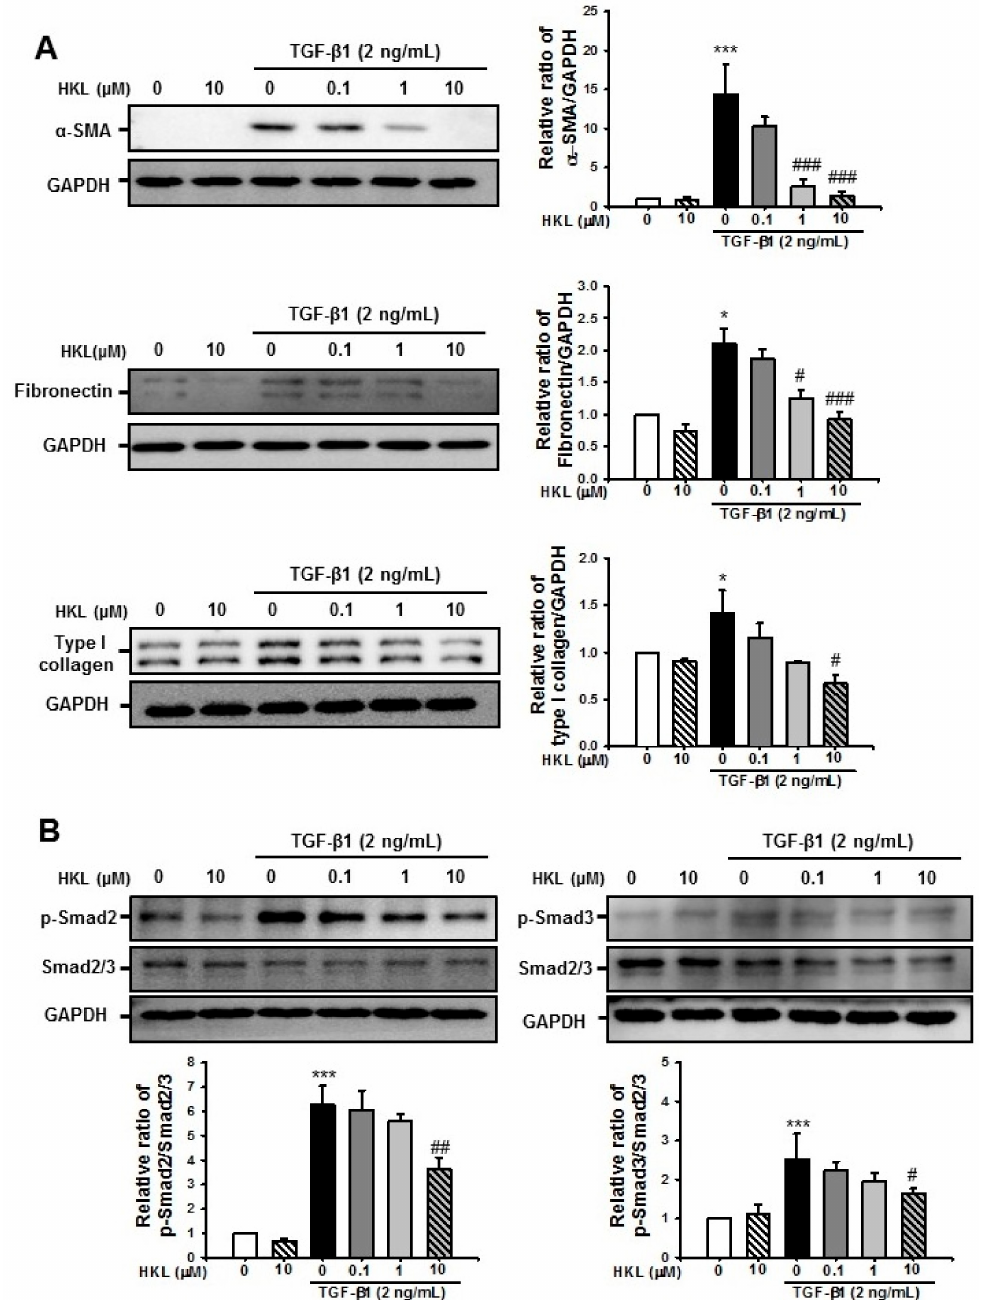
Figure 7. E ff ect of honokiol on transforming growth factor- β 1 (TGF- β 1)-induced fibroblast activation and extracellular matrix protein expression by regulation of the TGF- β 1 / Smad signaling pathway in NRK-49F cells ( A ) Representative Western blot for α -SMA, fibronectin, and type I collagen from NRK-49F cells treated with vehicle (Veh) or TGF- β 1 (2 ng / mL), with or without honokiol (HKL) at indicated doses (0.1, 1, and 10 µ M). Treatment with TGF- β 1 (2 ng / mL) for 24 h increased the expression of fibrotic markers. The expression of α -smooth muscle actin ( α -SMA), fibronectin, and type I collagen decreased after HKL treatment in a dose-dependent manner. The bar graph shows the densitometric quantification presented as the relative ratio of each protein to GAPDH. Data are presented as mean ±